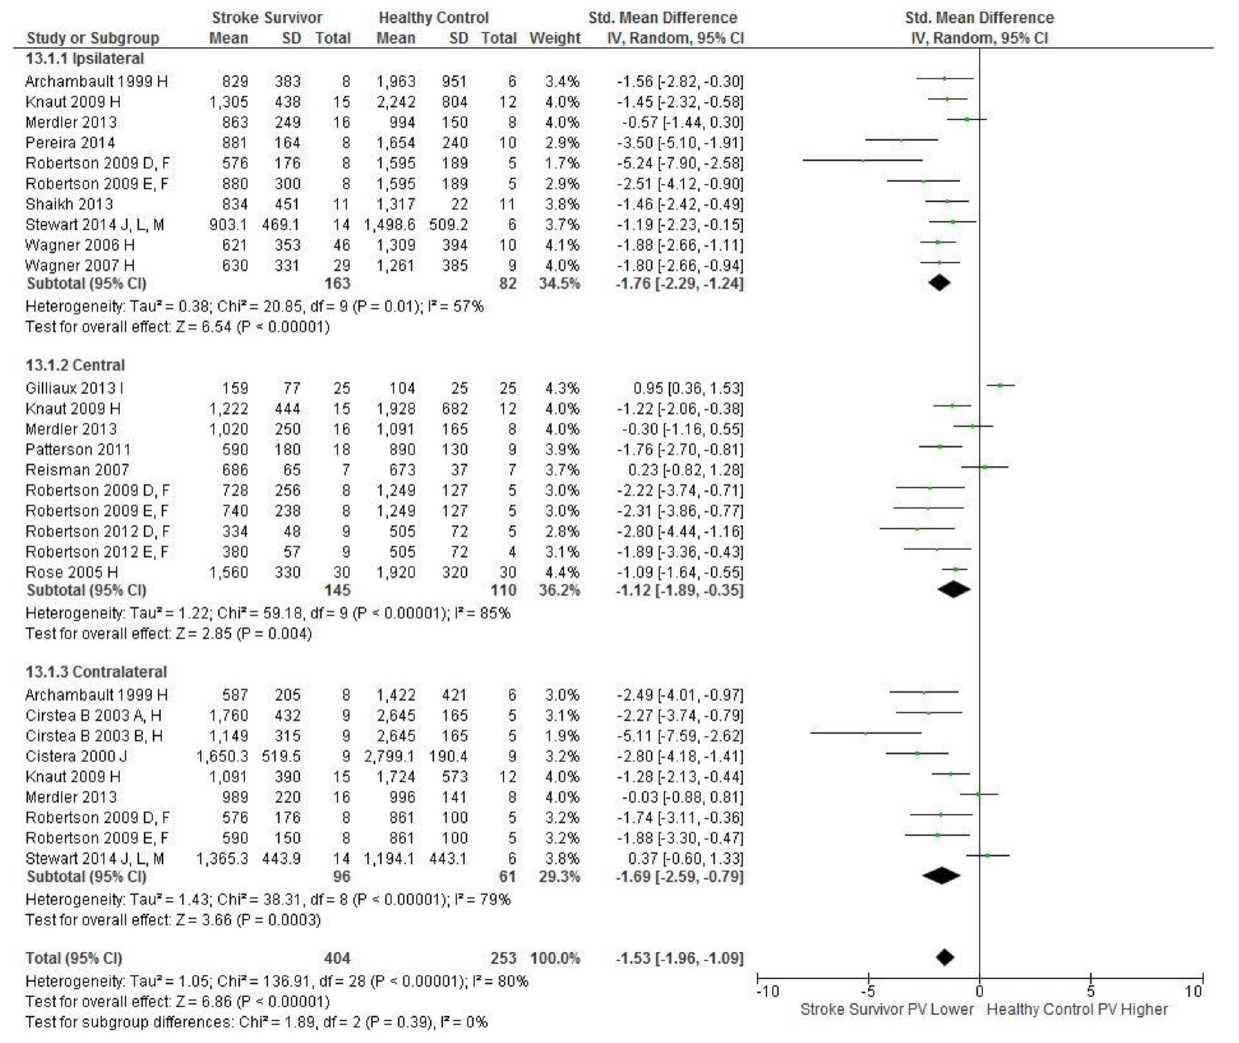
FIGURE 2 | The standardized mean difference (SMD) of peak velocity (mm/s) during reach-to-target in the: ipsilateral, central, and contralateral workspace. D, right hemisphere stroke; E, left hemisphere stroke; F, target placed 90% of arm’s length; H, fast speed; I, robotics; J, reaches without vision; L, 24cm target distance; M, virtual